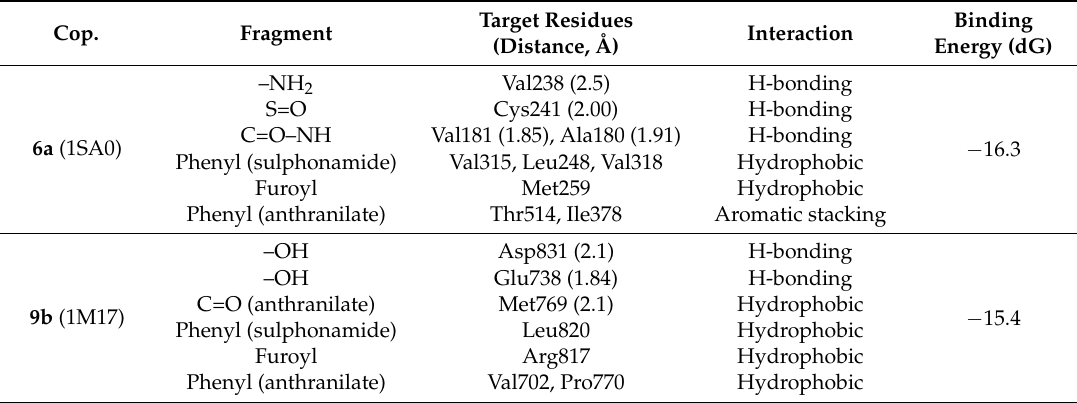
Table 3. Description of the docking data of selected target